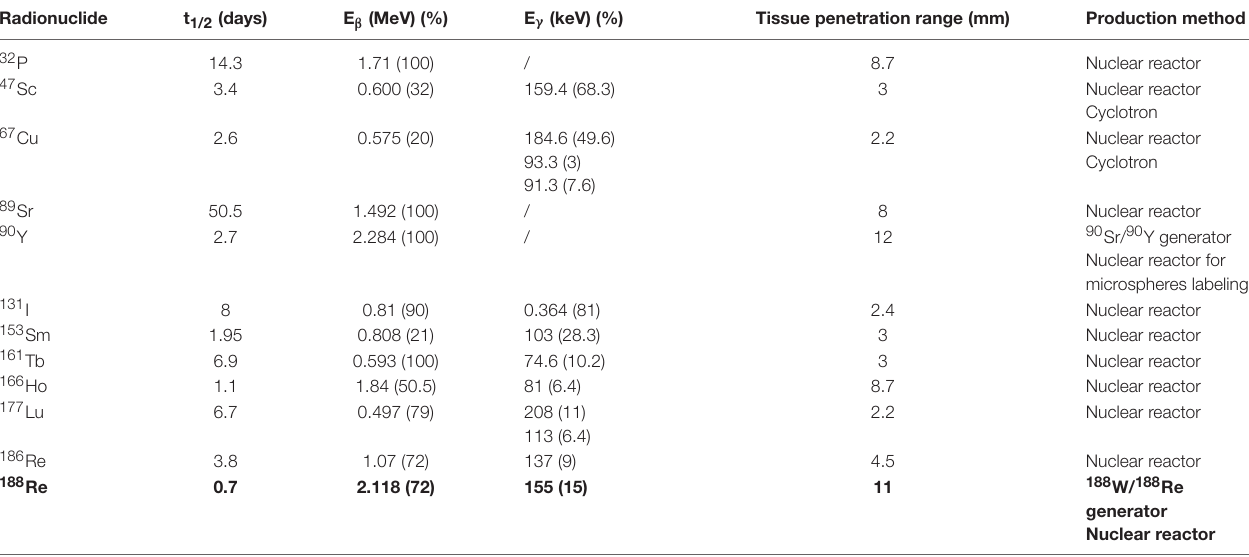
TABLE 1 | Characteristics of important β − emitters studied for radionuclide therapy.